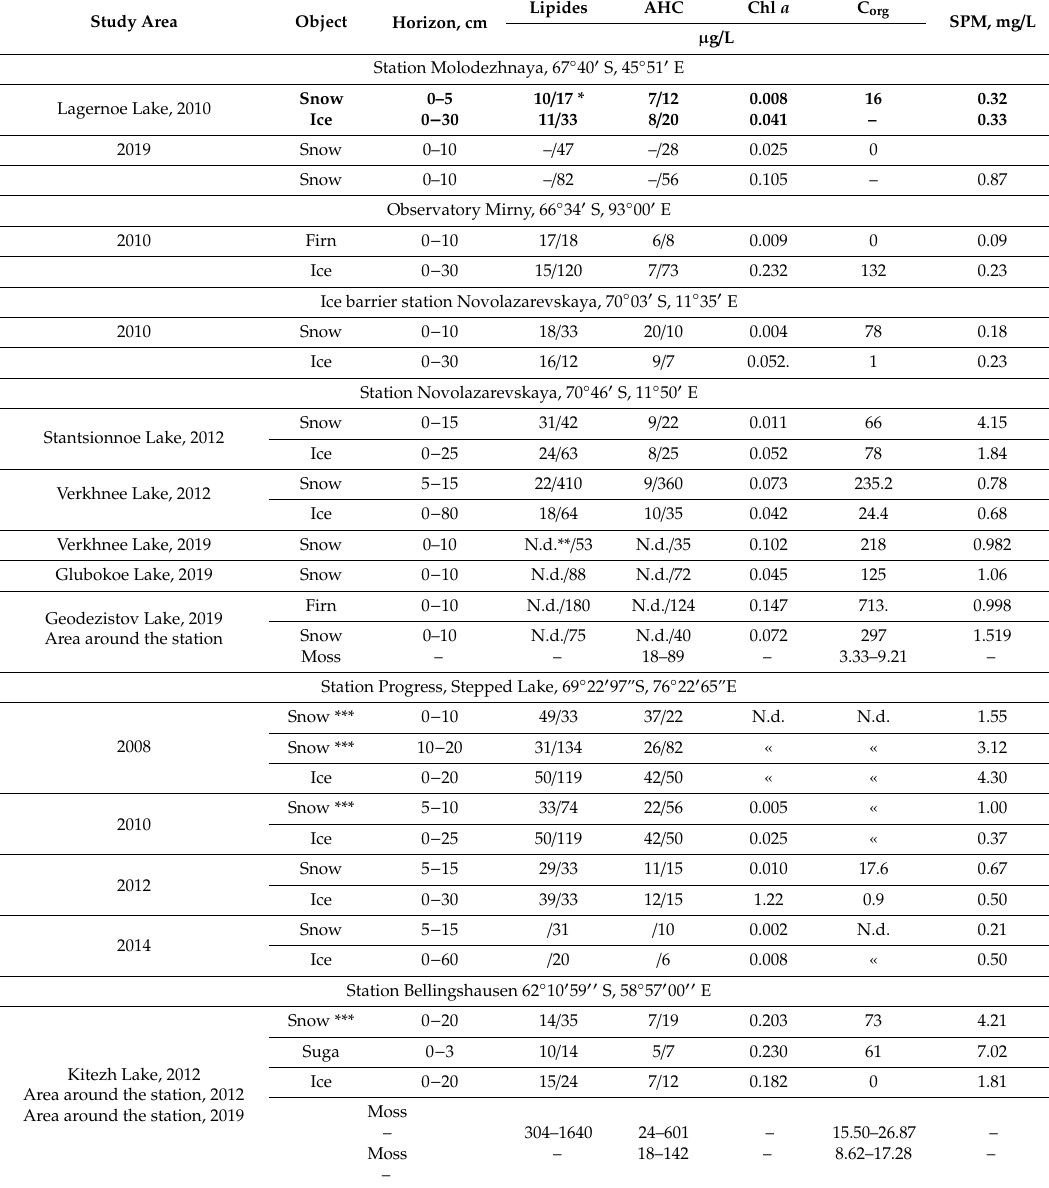
Table 3. The distribution of organic compounds and SPM in the snow-ice cover and in moss in the area of the Antarctic stations (in mosses, the concentration of AHC in µ g / g, and C org in %). Study